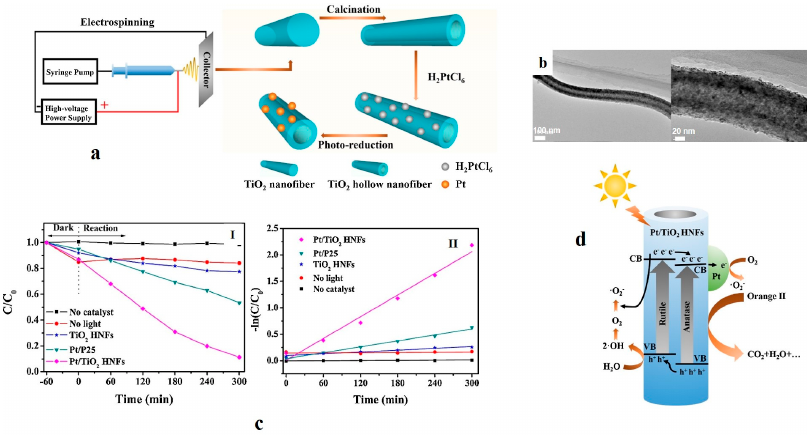
Figure 7. ( a ) The schematic illustration of the entire process of fabrication of Pt/TiO 2 hollow nanofibers (HNFs); ( b ) TEM image of the 2 wt % Pt/TiO 2 hollow nanofiber calcined at 350 °C at two magnifications (the scale bars are 100 and 20 nm); ( c ) Photodegradation of Orange II under visible light by various photocatalysts (I) and kinetic graphs relevant to the photodegradation of Orange II (II); ( d ) Schematic illustration of the photodegradation process of Orange II (Reproduced with permission from [112]. Elsevier, 2017).